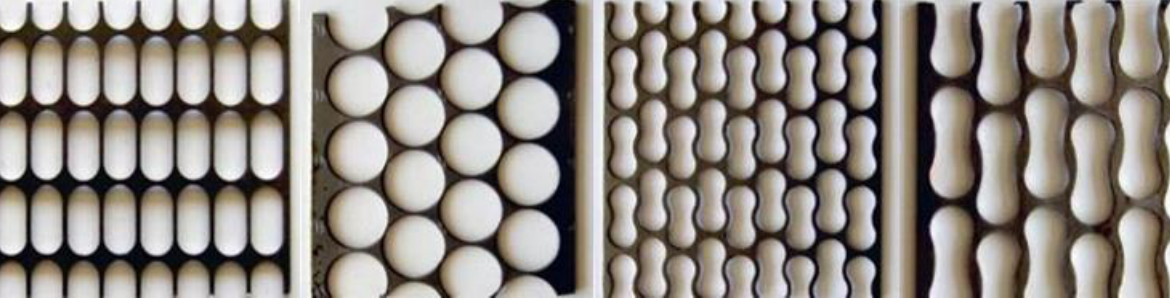
Figure 4. Some types of PMM residues with different shapes and sizes of hole samples.